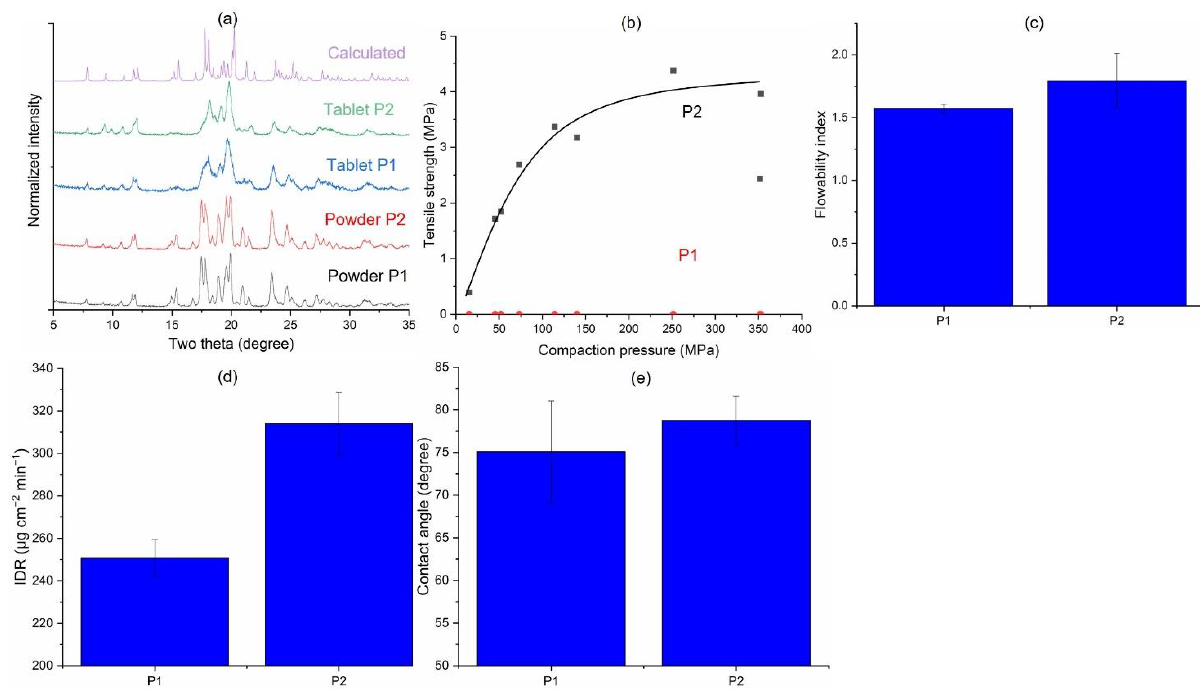
Figure 7. Solid-state characterization, bulk properties of Samples P1 and P2. ( a ) X-ray diffraction; ( b ) tabletability; ( c ) flowability; ( d ) intrinsic dissolution rate; ( e ) contact angle.